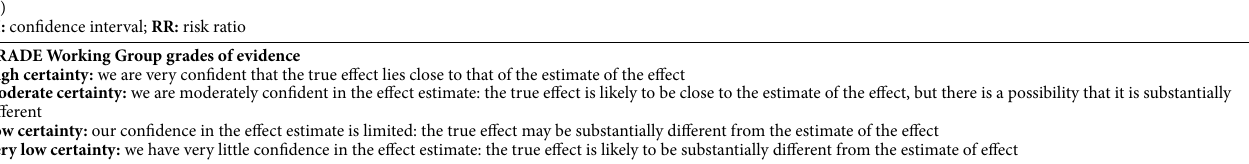
Table 4. Summary of findings. a Information used to generate the estimated effect obtained from studies with moderate risk of bias. b Information used to generate the estimated effect obtained from studies with severe risk of bias. c Mean operating time was reported without statistical analysis or standard deviation provided in the studies included. d Estimated blood loss across studies had a large variations and standard deviation values. e Estimated blood loss was reported without statistical analysis or standard deviation provided in the study included. f Large amount of heterogeneity within results with results approaching the line of no effect. g Length of Stay was reported without statistical analysis or standard deviation provided in the studies included. h Small number of studies included for